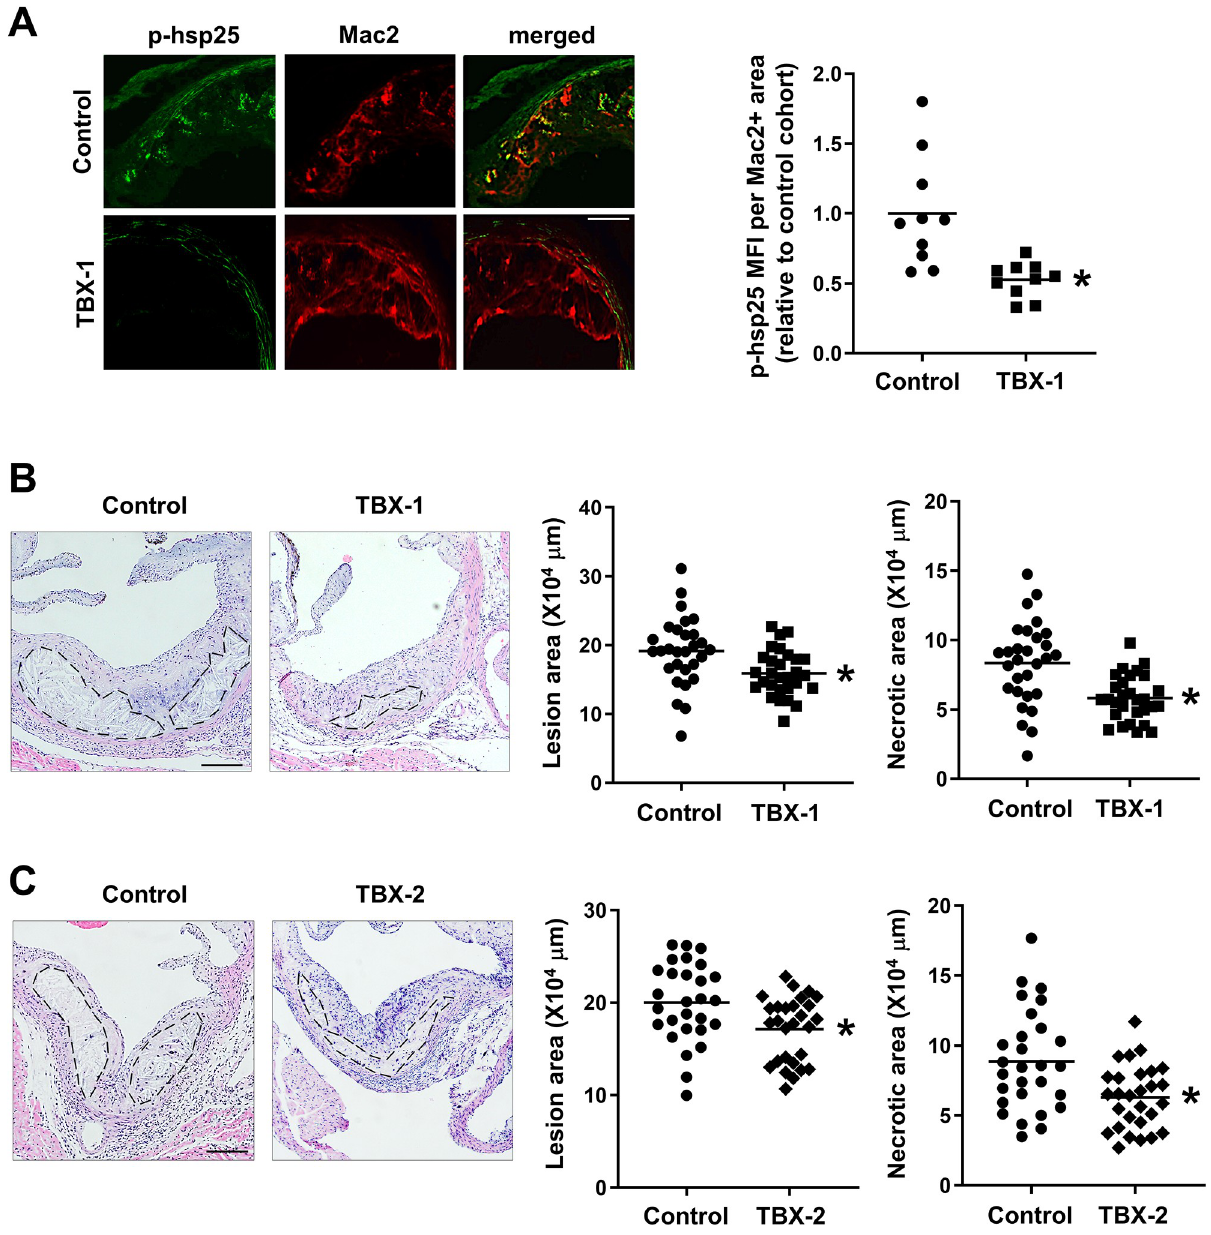
Fig 3. MK2 inhibitor treatment lowers p-hsp25, lesion size, and plaque necrosis in aortic root lesions of WD-fed Ldlr -/- mice. Mice were treated as in Fig 1. ( A ) Aortic root sections from a randomly selected subset of Ldlr -/- mice treated with TBX-1 were co-immunostained for phospho-hsp25 (p- hsp25, green) and Mac2 (red). Scale bar: 50 μ m. Phospho-hsp25 staining was quantified as mean fluorescence intensity (MFI) within Mac2 + area. Data are presented relative to the average value obtained from the control group (n = 10 mice/group; mean ± SEM, p = 0.001). ( B-C ) Total lesion area and necrotic area were quantified from the aortic root sections of Ldlr -/- mice treated with TBX-1 (B) or TBX-2 (C). Representative images with necrotic cores outlined in black are shown. Scale bar: 150 μ m (n = 29 mice/group for TBX-1 and n = 28 mice/group for TBX-2; mean ± SEM, p = 0.006, p < 0.001, p = 0.008 and p = 0.002,